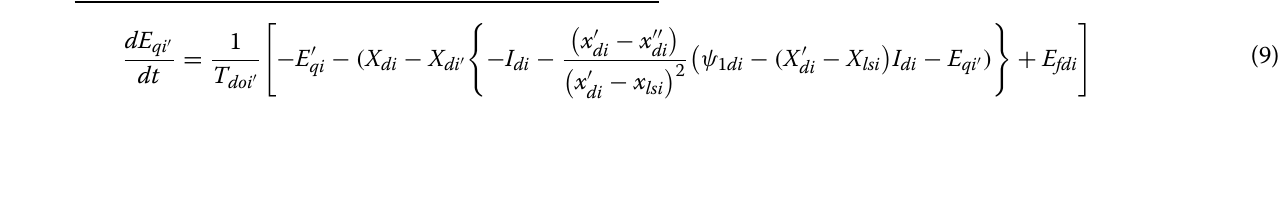
reactances, respectively. T ′′ qoi and T ′ qoi are the q-axis sub- transient and transient time constants, respectively.